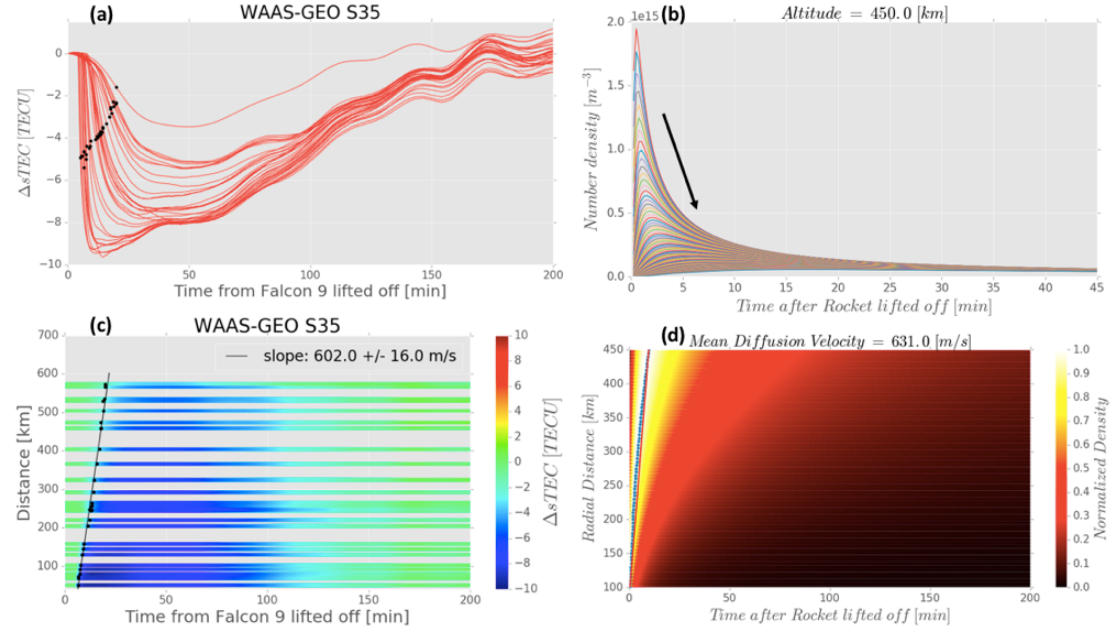
Figure 6. ( a , c ) The filtered VARION-GEO ∆ sTEC solutions for satellite S35. The black dots represent 50% of the minimum of ∆ sTEC . ( c ) The ∆ sTEC solutions plotted on a time vs. distance plot. We interpolated the black dots to estimate a mean expansion velocity of the ionospheric hole. ( b , d ) The results of the diffusion simulation at 450 km of altitude. ( b ) The density time series at a fixed distance from the diffusion point. Following the black arrow, we computed the curves from 100 to 600 km, every 5 km. ( d ) The time vs. distance plot for the simulation. We computed the mean diffusion velocity of the number density